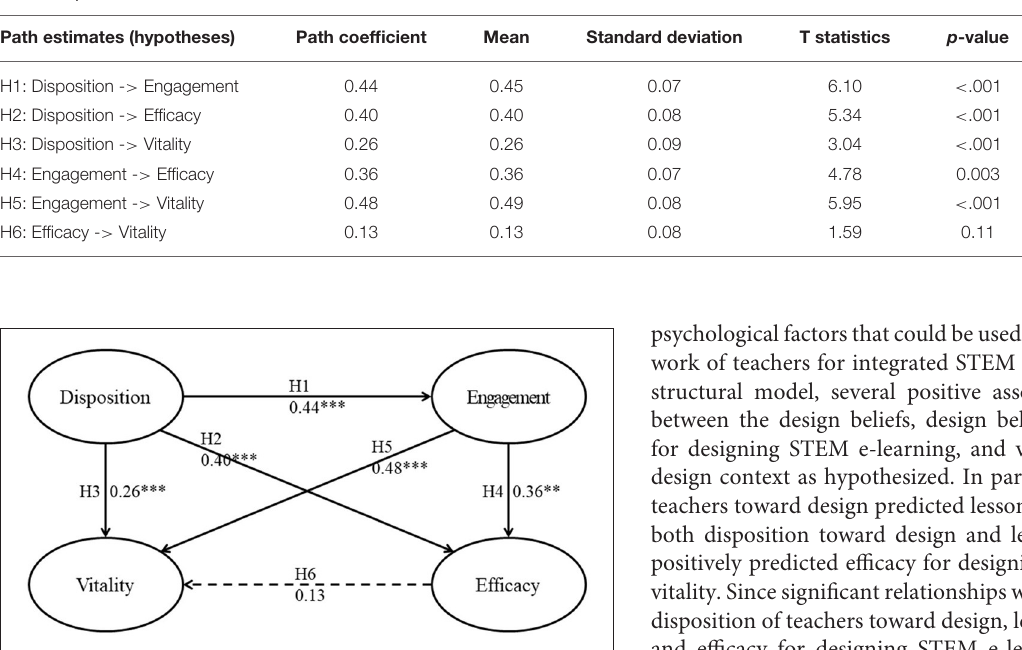
TABLE 3 | Path estimated of the structural model.